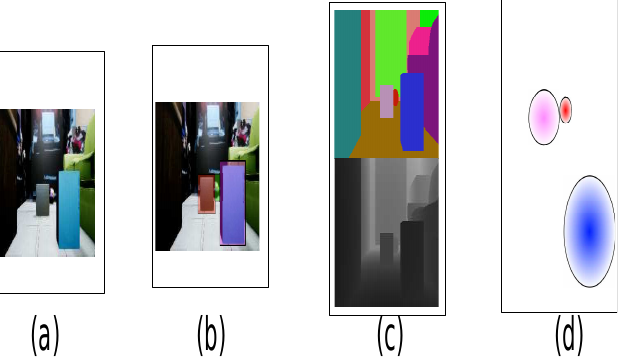
Figure 9. Process to estimate the location of objects. ( a ) Standard input sample. ( b ) Object’s detection. ( c ) Semantic mask and depth samples. ( d ) Estimation of the object